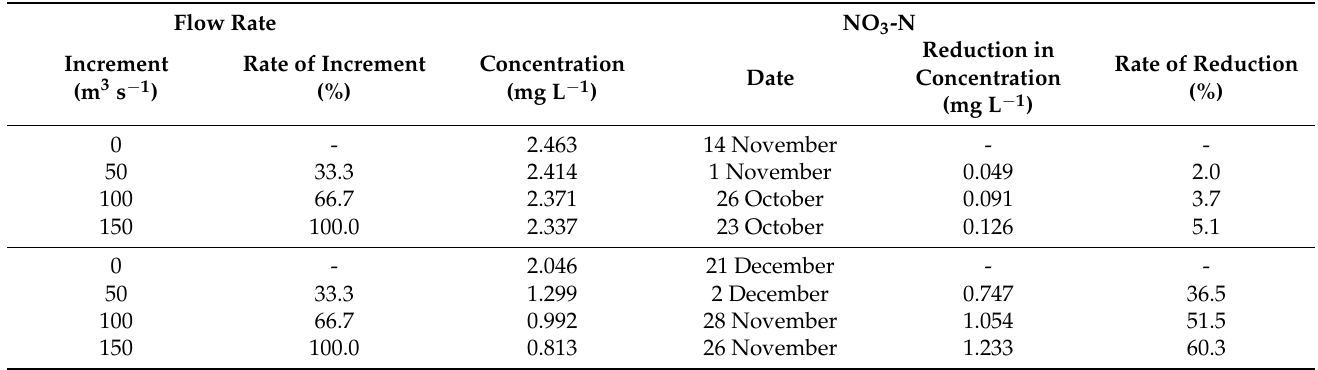
Table 10. Example, taken from the red ellipses in Figure 8b, of the change in NO 3 -N concentration produced by an increase in flow rate.